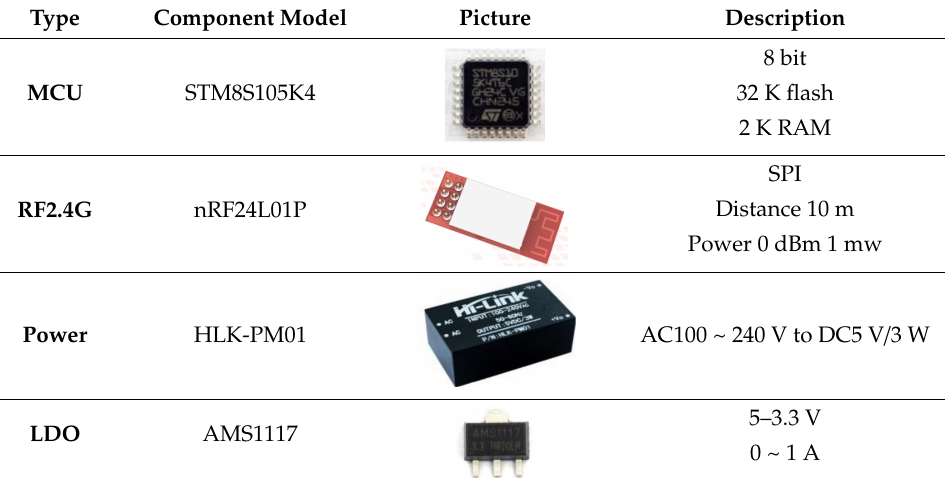
Figure 5. LED driver control block diagram and working board. Table 4. Main components of LED driver control.